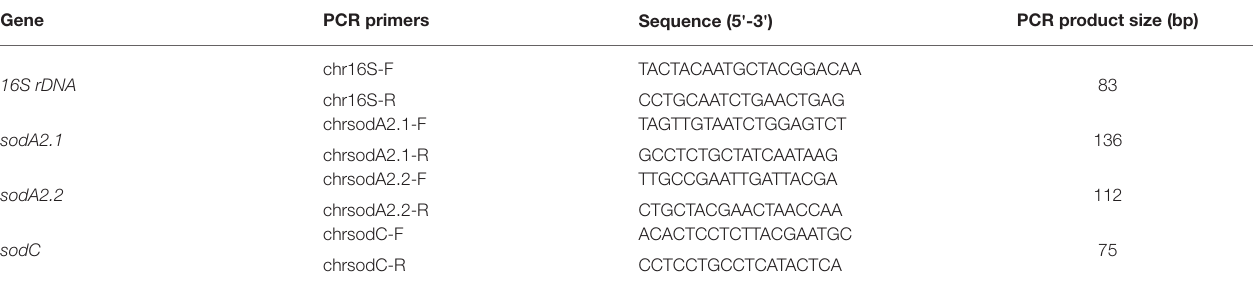
TABLE 1 | Primers used for real-time quantitative PCR